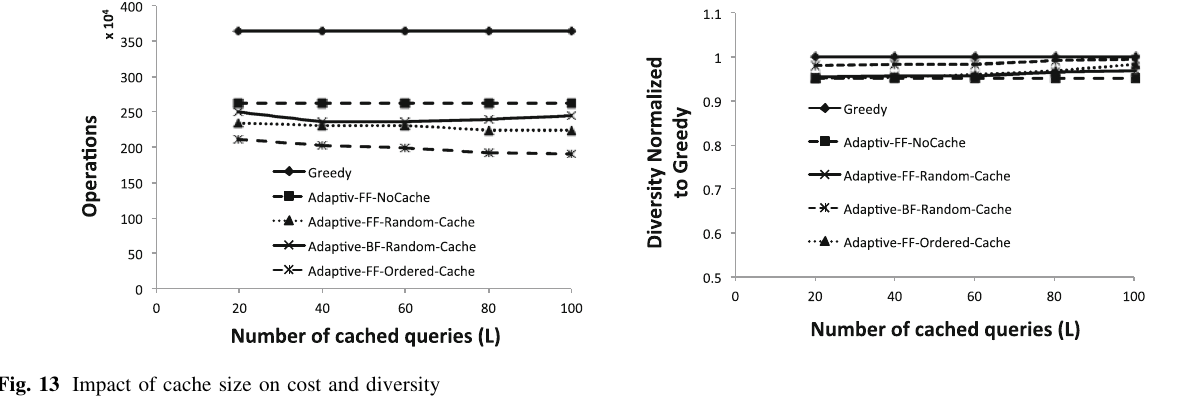
Fig. 13 Impact of cache size on cost and diversity